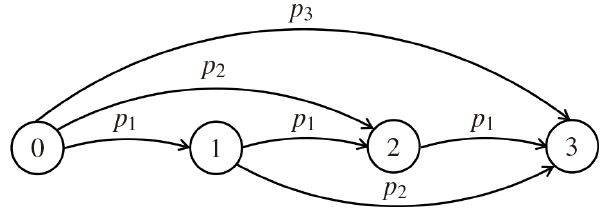
Figure 1. Simple opportunistic network for N =